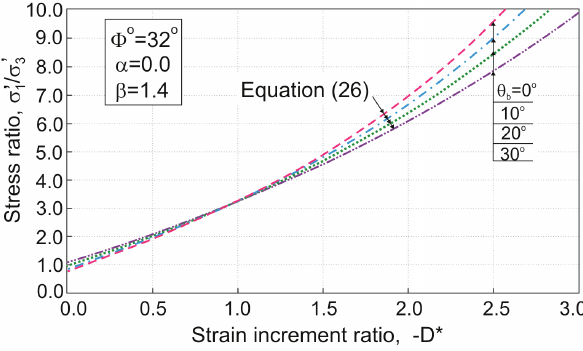
Fig. 2. Influence of angle  b on the stress ratio